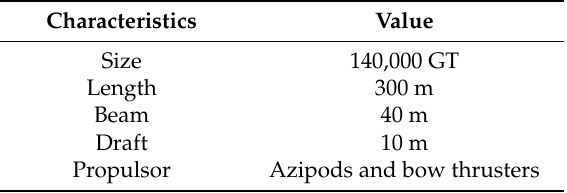
Table 3. Investigated cruise ship characteristics.